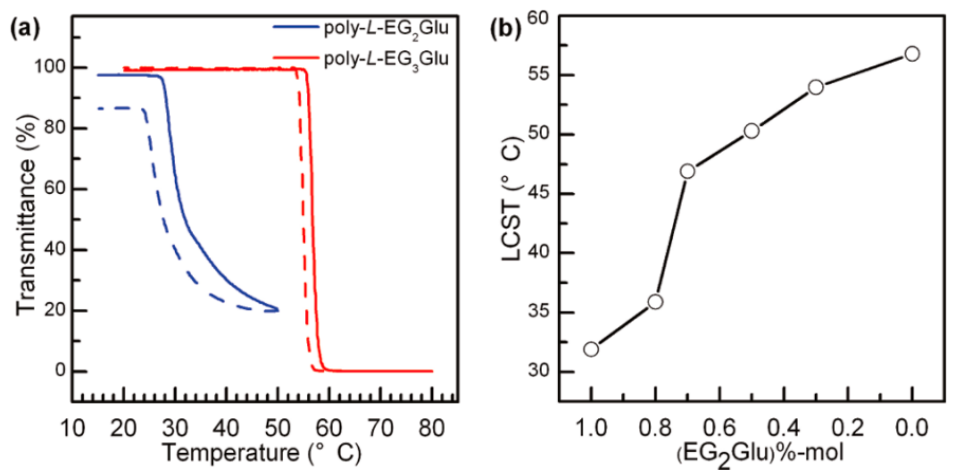
Figure 3. ( a ) Plots of transmittance as a function of temperature for aqueous solutions (2 mg/mL) of poly- L -EG 2 Glu and poly- L -EG 3 Glu. Solid line: heating; dashed line: cooling. ( b ) LCST of poly(EG 2 Glu-EG 3 Glu) copolymers as a function of sample composition. Reproduced with permis- sion [34]. Copyright 2011, American Chemical Society.